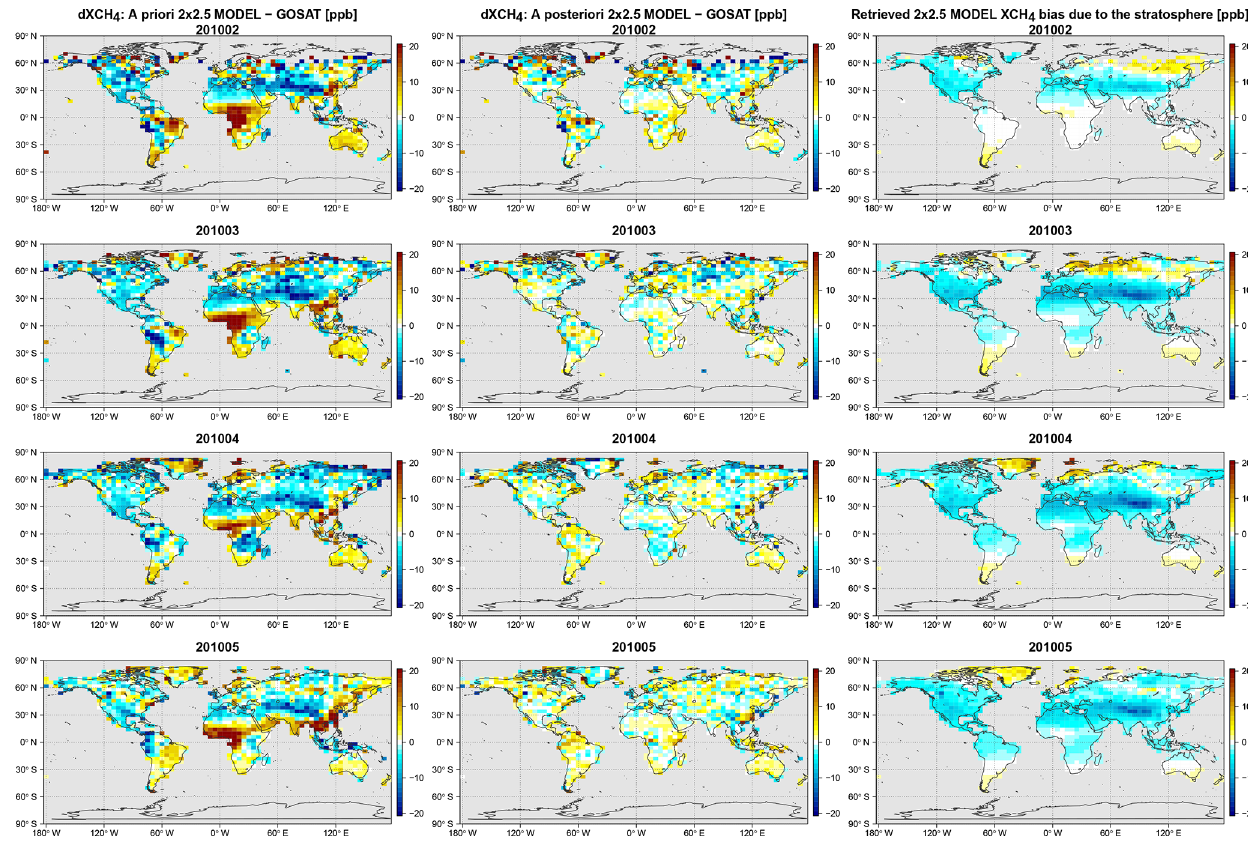
Figure 7. Same as Fig. 6 but for the 2 ◦ × 2.5 ◦ resolution